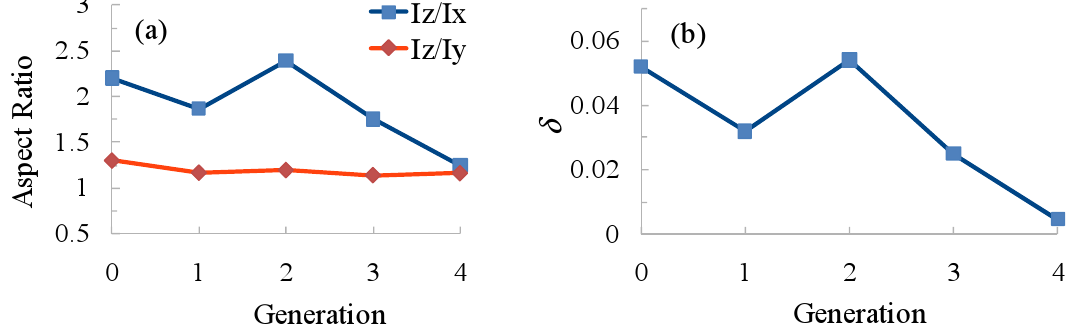
Figure 8. ( a ) Average aspect ratios I anisotropy δ for the